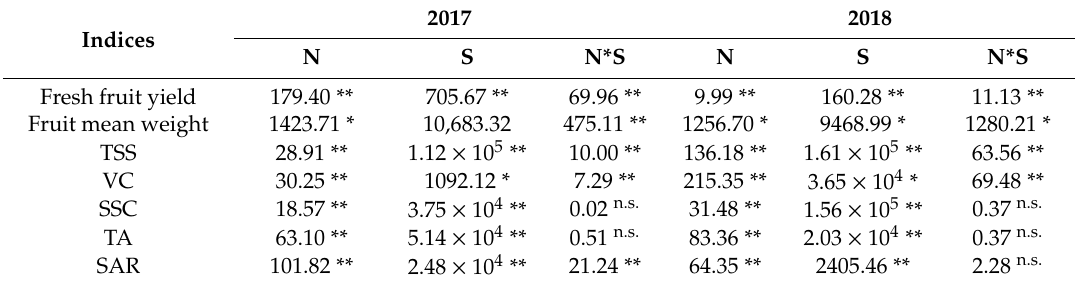
Table 4. Results of the two-way ANOVA for each analysis index of processing